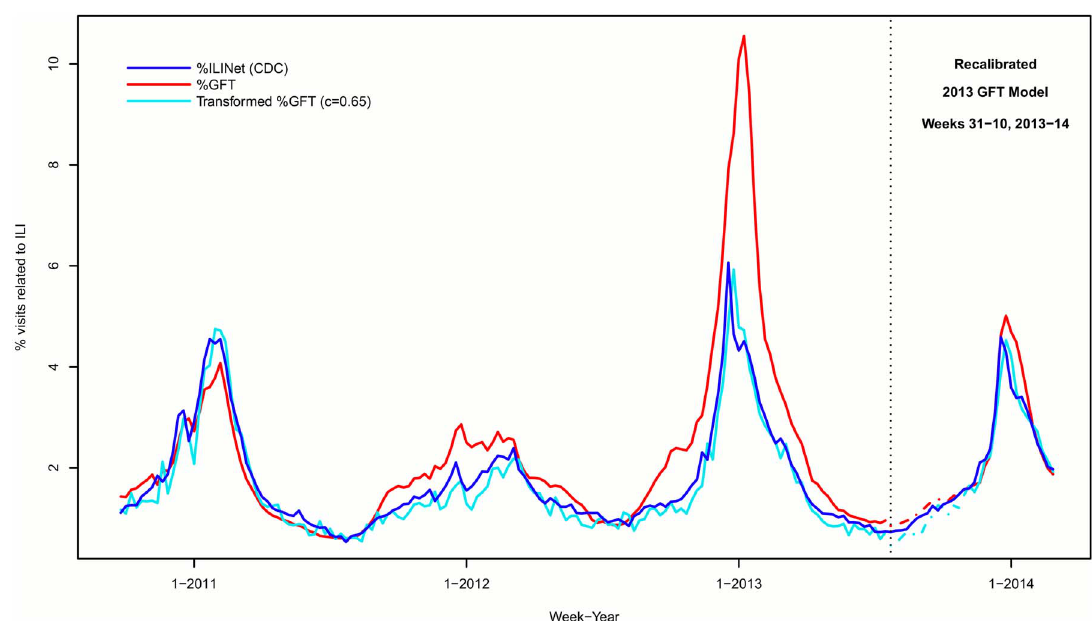
Fig. 1. Weekly percentage of sentinel physician visits related to influenza-like illness (ILI) reported by the Centers for Disease Control and Prevention (CDC) and estimated using Google Flu Trends (GFT), United States, October 2010–March 2014. The final CDC value (f%ILINet; blue) is compared to the GFT estimate (%GFT; red) and the transformed GFT estimate using c 5 0.65 (transformed %GFT; turquoise). The GFT model was recalibrated during the 2013–14 season: dashed lines show the period in which GFTestimates were retrospectively re-estimated using the 2013 GFT